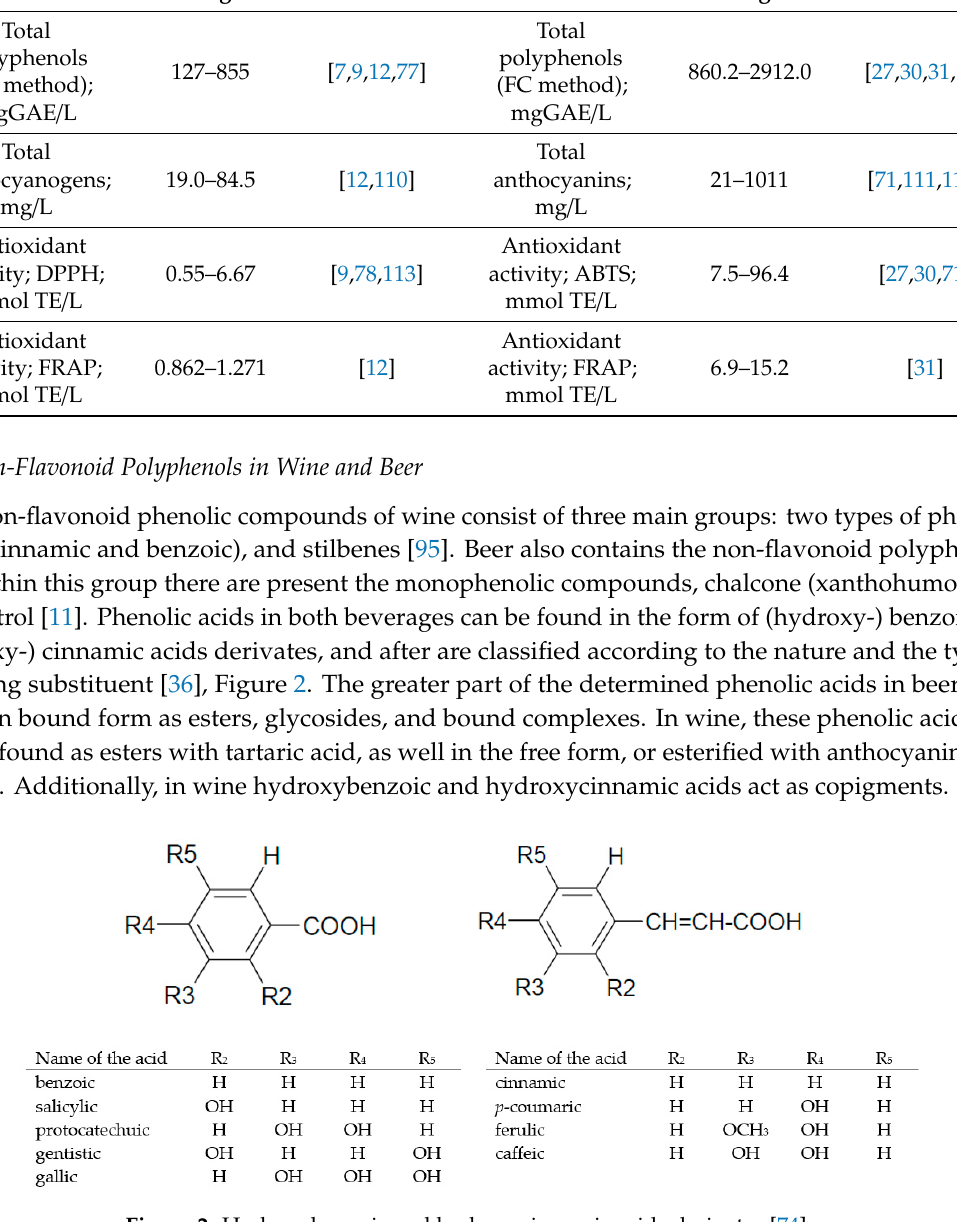
Figure 2. Hydroxybenzoic and hydroxycinnamic acids derivates [74].